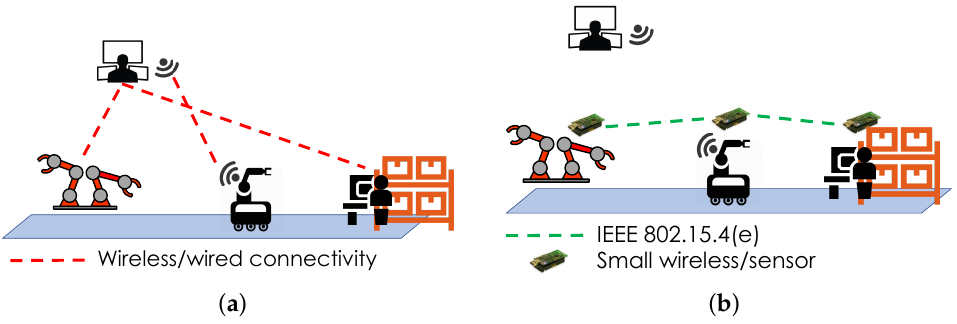
Figure 7. First test case set-up. ( a ) Backbone network operational; ( b ) backbone network not